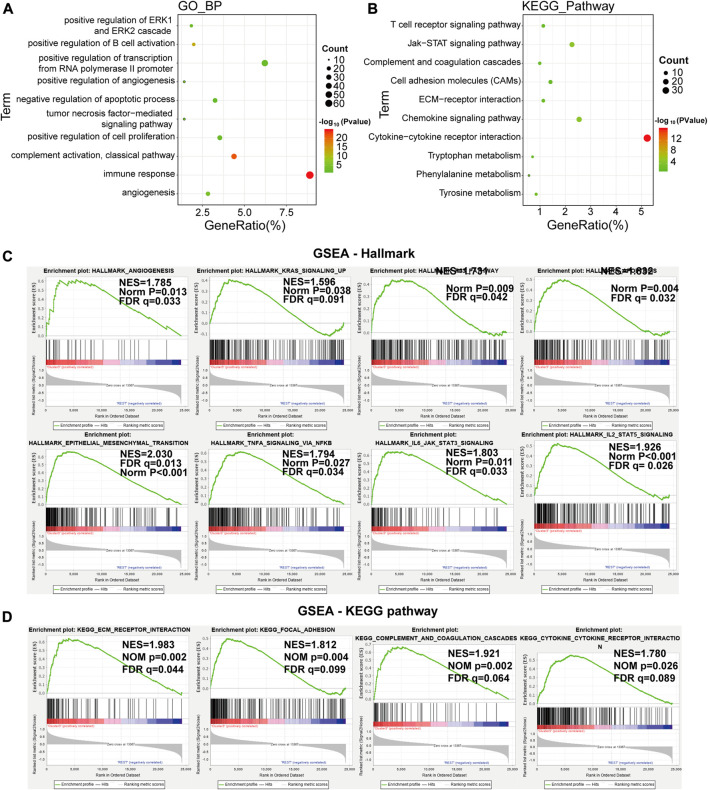

(A), (B) Functional annotation of the genes with higher expression in the LA3 subgroup using gene ontology (GO) terms of biological processes (A) and Kyoto Encyclopedia of Genes and Genomes (KEGG) pathway (B) analyses. (C) Gene set enrichment analysis indicated that genes with higher expression in the LA3 subgroup were enriched for hallmarks of malignant tumors.